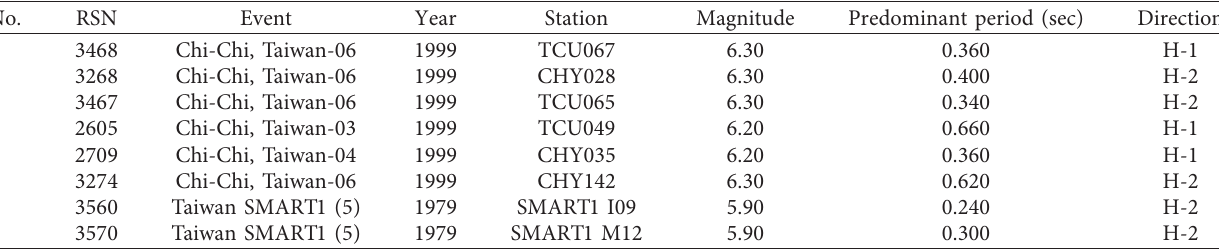
Table 2: Selected records for aftershocks.